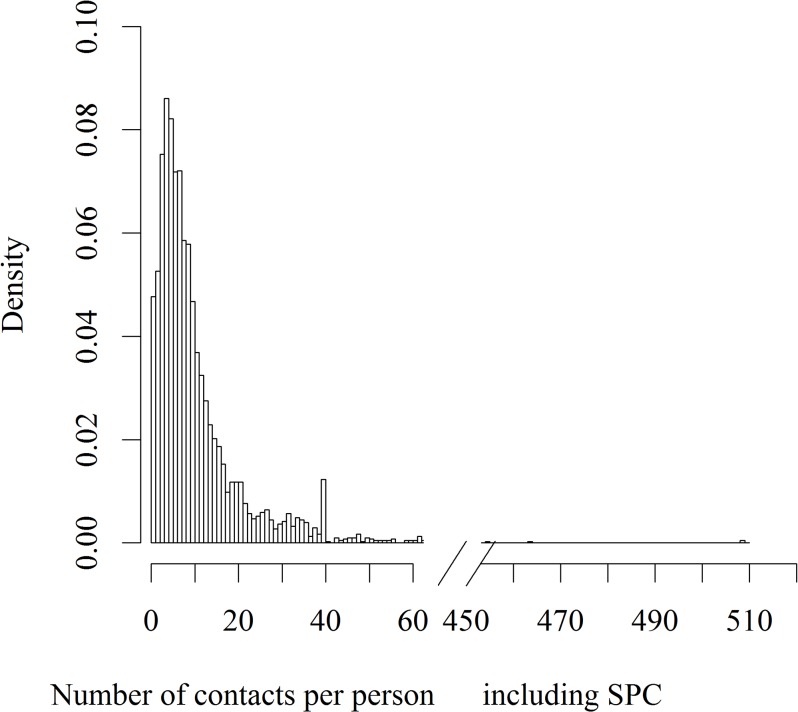
Contact number density.Histogram of the contact number, including SPC (Supplementary Professional Contacts). Limitation at 40 contacts per day explains the peak at 40 contacts.